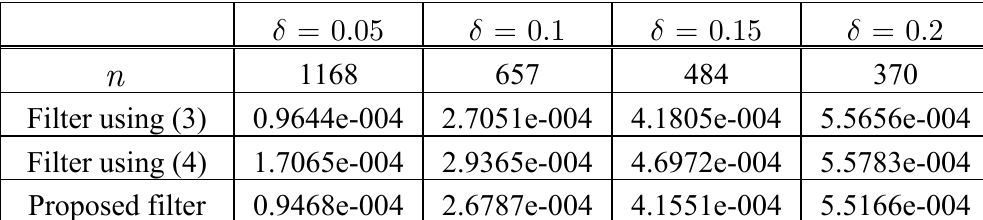
Table 2. Estimation error with different δ values in case 2.